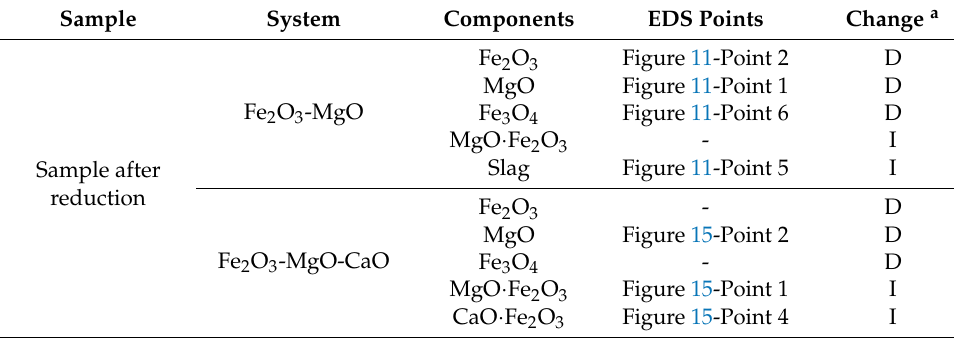
Table 10. Effect of fine LCM on the mineral composition of sample after reduction.